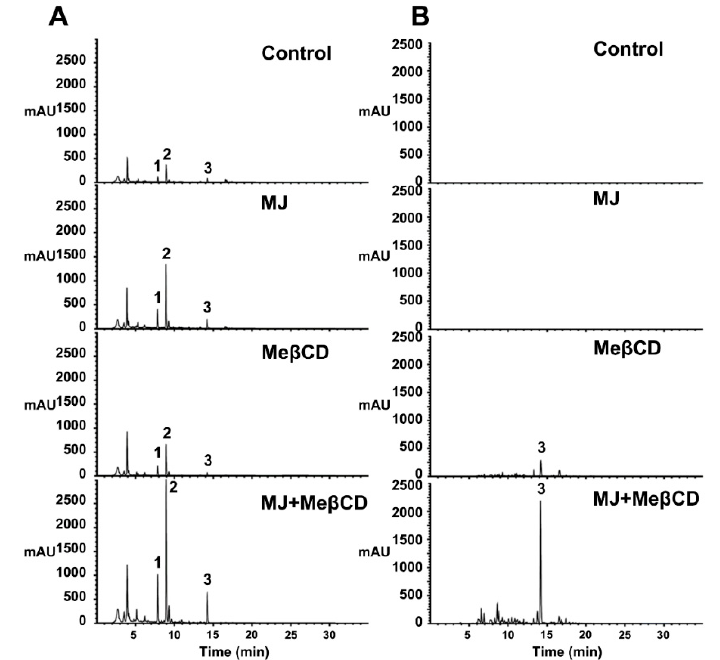
Figure 6. Enhanced production of pterocarpans by MJ and Me β CD co-treatment in the S. flavescens cell cultures. ( A ) Synergistic e ff ect of MJ and Me β CD on pterocarpan production in the cells. ( B ) Extracellular production of maackiain in the culture medium. Cells were pre-cultured for 7 days and harvested 7 days after co-treatment with 50 µ M MJ and 50 mM Me β CD. Peaks 1 (7.86 min), 2 (8.94 min), and 3 (14.21 min) on the chromatograms represent the peaks identical to the retention times of the authentic standards, trifolirhizin, trifolirhizin malonate, and maackiain, respectively. The culture medium was extracted with ethyl acetate and analyzed by HPLC.